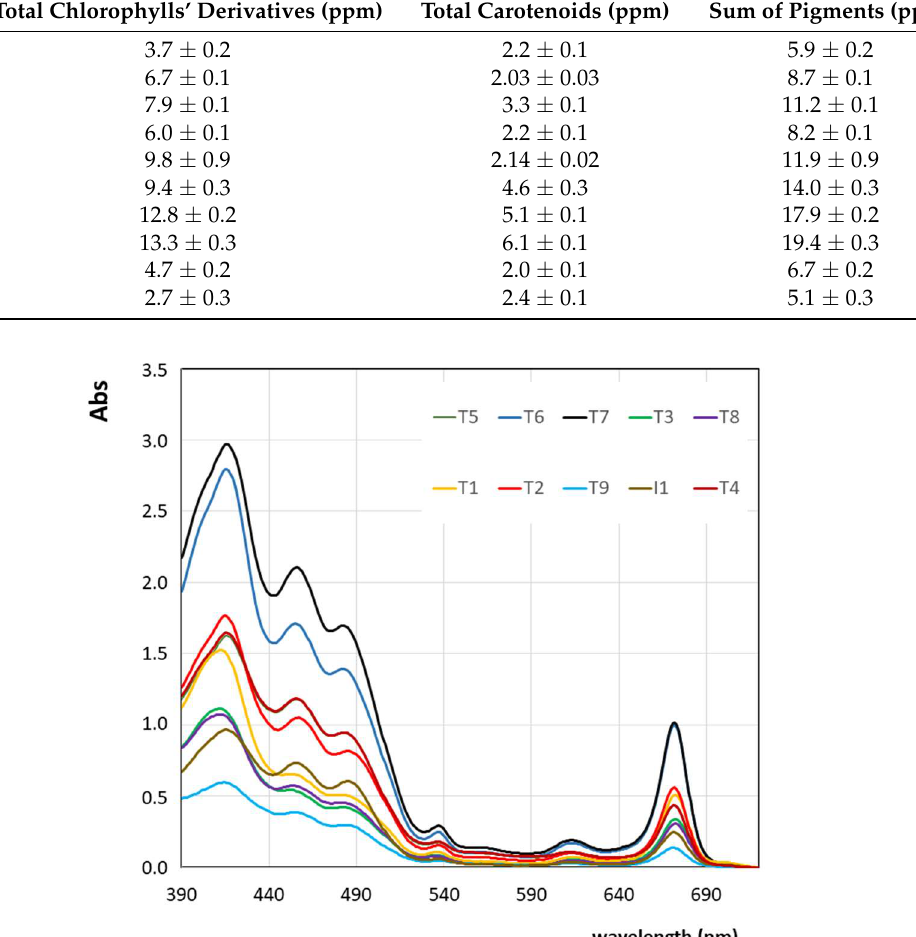
Figure 2. Superposition of experimental near UV-vis absorption spectra of the EVOO and VOO samples under investigations, as indicated in Table 1 and on the legend. The absorption spectra are scaled in order to have zero absorption (Abs = 0) at wavelengths larger than 720 nm.